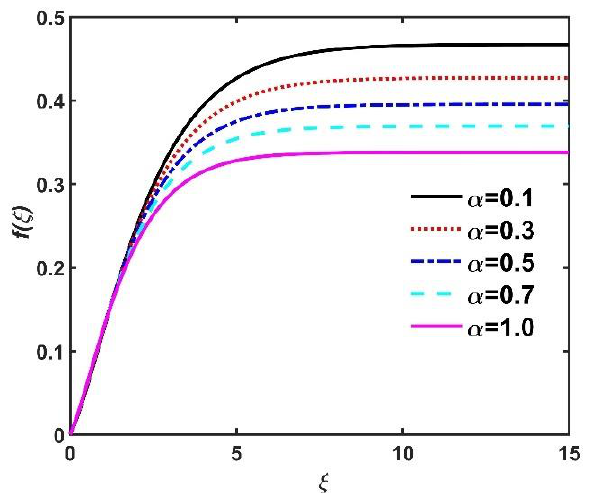
Figure 4. Impact of 𝛼 on 𝑓(𝜉) .